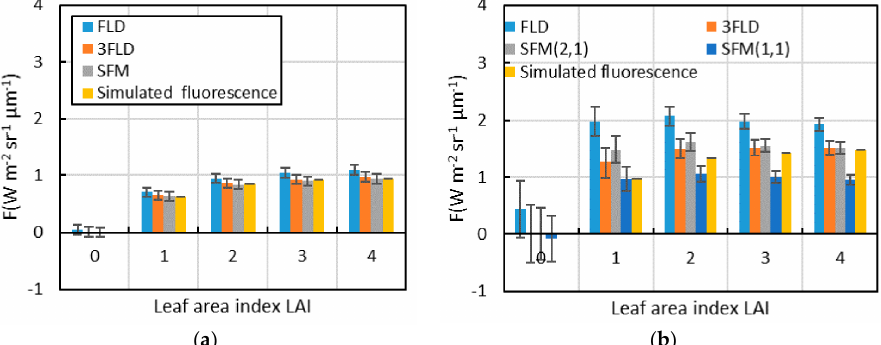
Figure 7. The fluorescence extraction results of each algorithm and the simulated value of fluorescence for data with different leaf area indices (the rectangle in this Figure is the mean fluorescence, and the error lines is the standard deviation); ( a ) O 2 -A absorption band; ( b ) O 2 -B absorption band.